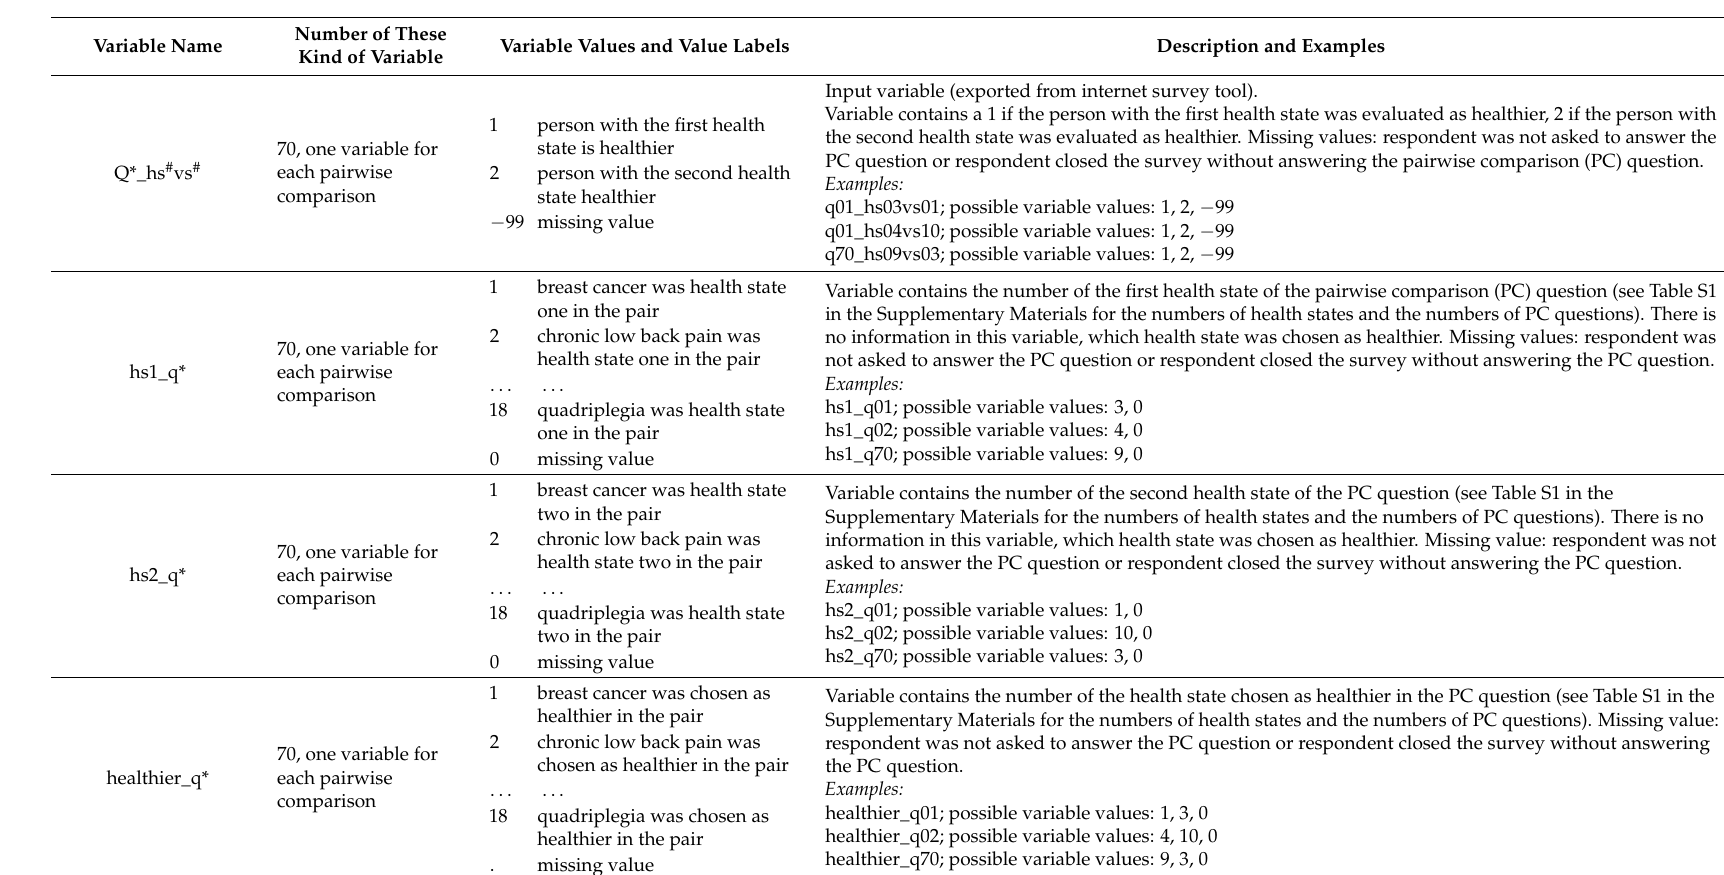
Table 1. List of